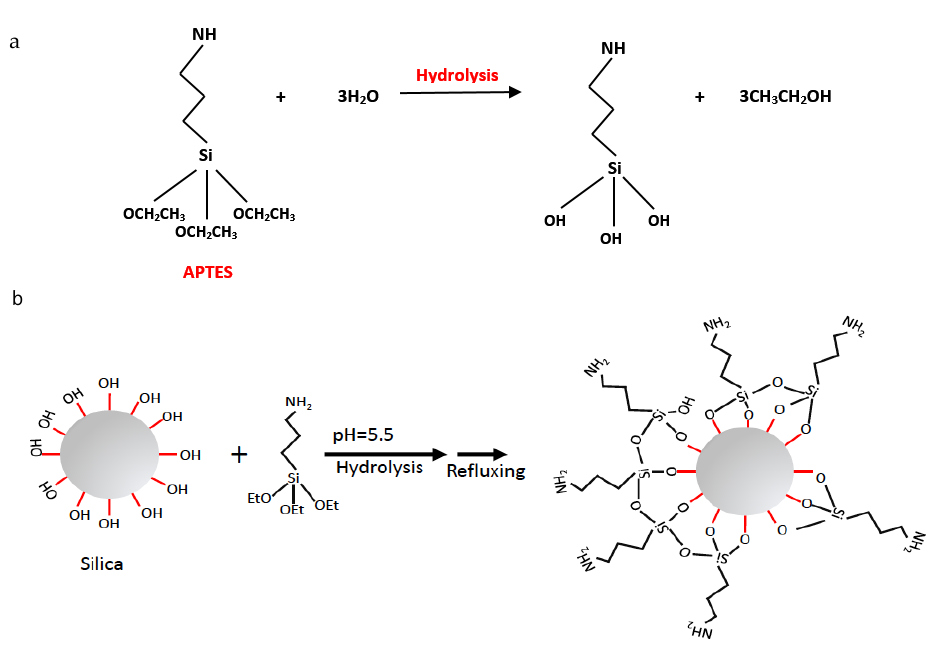
Figure 1. Schematic representation of the reaction of 3-aminopropyl triethoxysilane (APTES) functionalized silica particles in water: ( a ) Hydrolysis and ( b ) condensation reactions.